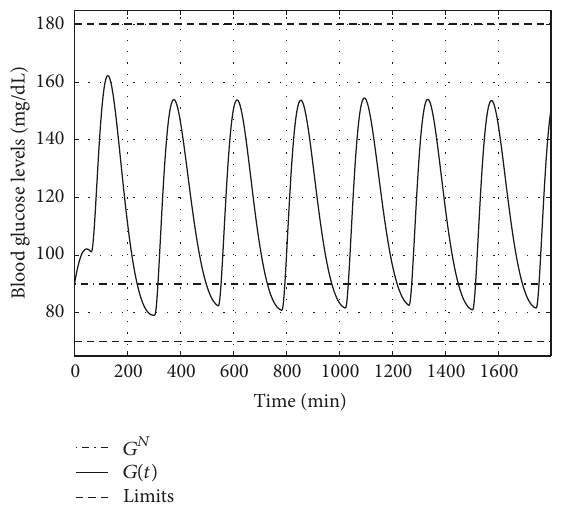
Figure 16: Variation of the blood glucose level over time.